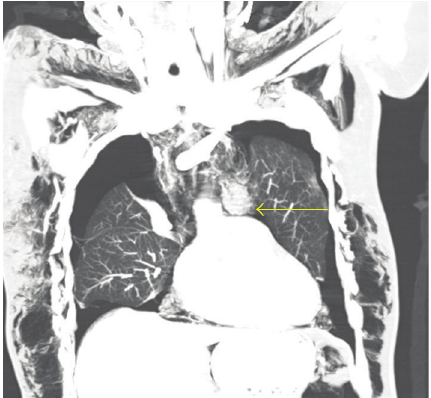
Figure 3: Coronal section of CT thorax showing subcutaneous emphysema, bilateral pneumothorax, and pneumomediastinum